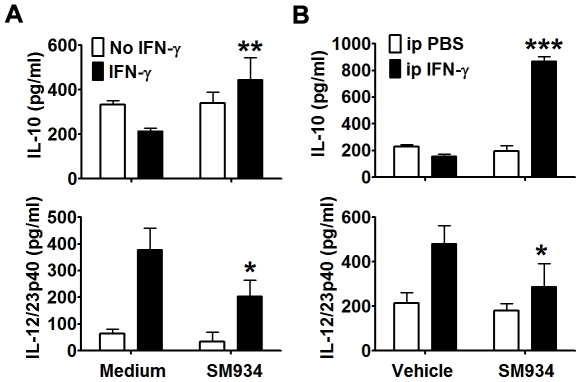
SM934 induced IL-10 production from IFN-γ-challenged macrophages in vitro and ex vivo.(A) Peritoneal macrophages were isolated from naïve C57BL/6 mice and then were in vitro stimulated with mIFN-γ in the presence or absence of SM934 for 24 hours. IL-10 (UP-panel) and IL-12/23p40 (Bottom-panel) productions in the supernatants were examined by ELISA. (B) C57BL/6 mice were i.p. elicited with mIFN-γ and orally administrated with vehicle or SM934 (10 mg/kg) for 3 days. Then, peritoneal macrophages were cultured with medium for 24 hours and supernatant IL-10 (UP-panel) and IL-12/23p40 (Bottom-panel) were examined by ELISA. Bars showed the mean ± SD of 3 independent experiments. * = P<0.05, ** = P<0.01, *** = P<0.001 versus corresponding medium or vehicle control with similar stimulatory condition.